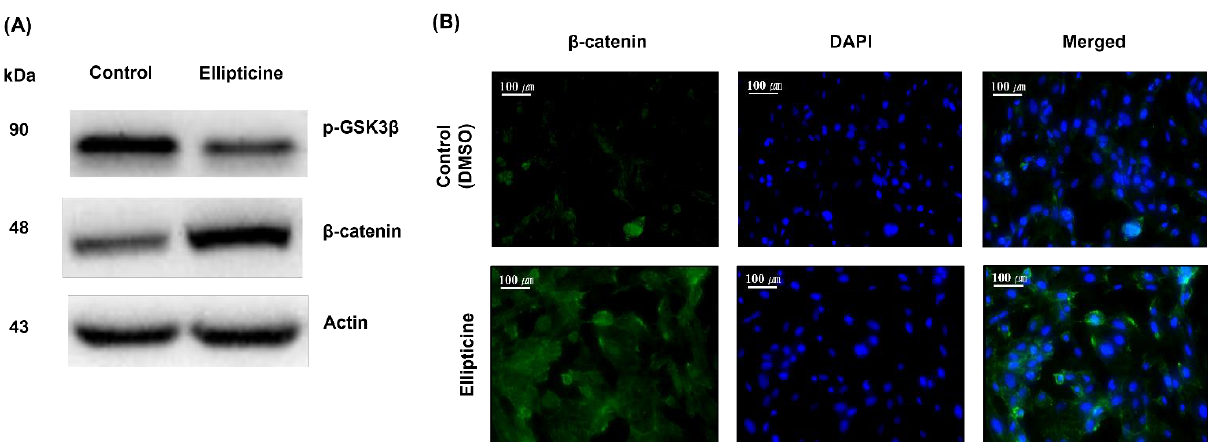
Figure 4. Evaluation of the activity of the candidate chemical ellipticine. HUVECs were treated with 156.25 nM ellipticine for 8 h. After the treatments, the cell lysates were extracted and the levels of phosphorylated GSK-3β and β-catenin expression were analyzed by western blotting using specific antibodies ( A ). Actin control was included. Immunofluorescence assay revealed that the expression of β-catenin (green) in ellipticine-treated cells was significantly enhanced compared to the control. Nuclei were counterstained with DAPI (blue) ( B ). (40× magnification, scale bar = 10 μm).